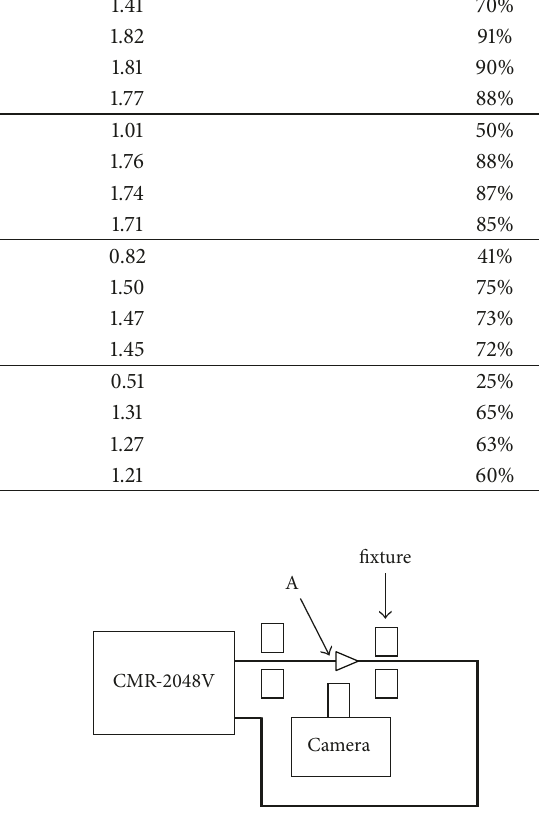
Figure 7: The experiment of bit error rate test.